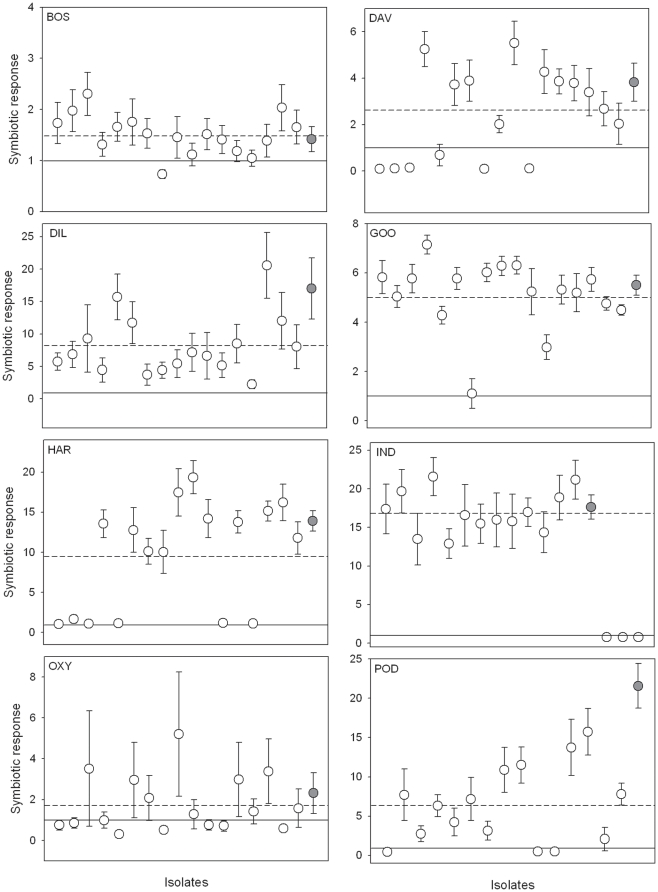
Symbiotic response of the eight host plants to rhizobial strains originally collected from the same host species, and to the broadly effective Acacia control strain (WG; filled circles).The solid line at 1 on the y-axis indicates the growth response level where the host did not gain or lose anything from the rhizobial interaction relative to the N− control treatment. Symbiotic response values <1 indicate a negative response, and values >1 indicate a positive effect of inoculation. The dashed line is the average symbiotic response to all rhizobial strains. Error bars are based on standard errors of means (if not visible, they are smaller than the symbols). BOS = Bossiaea foliosa, DAV = Daviesia ulicifolia, DIL = Dillwynia retorta, GOO = Goodia lotifolia, HAR = Hardenbergia violacea, IND = Indigofera australis, OXY = Oxylobium ellipticum, and POD = Podolobium ilicifolium. Note the different y-axis scales between figure panels.